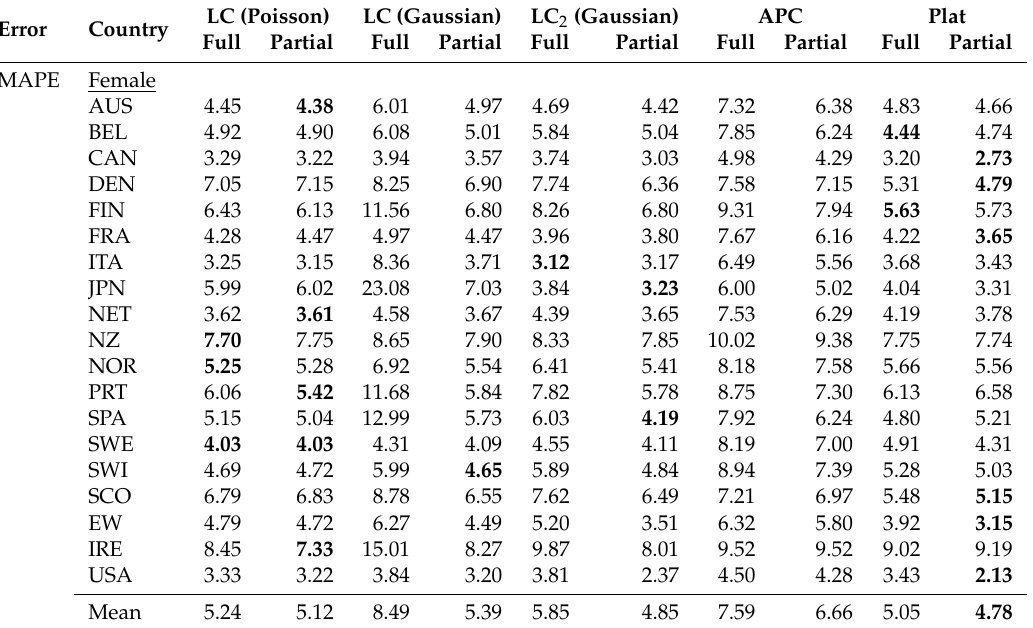
Table 2. For the one-step-ahead forecast horizon h = 1, we compute the MAPE and RMSPE for each country and each model. The most accurate model for each country is highlighted in bold. For each model, we consider modeling the data with either a partial age range (termed as Partial) or a full age range (termed as